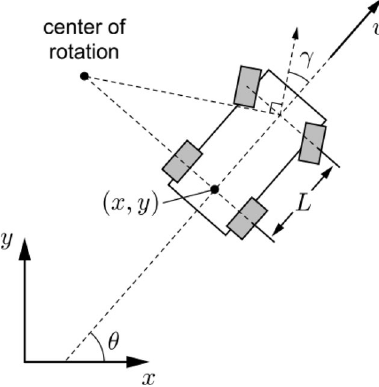
Figure 1. Vehicle Dynamics